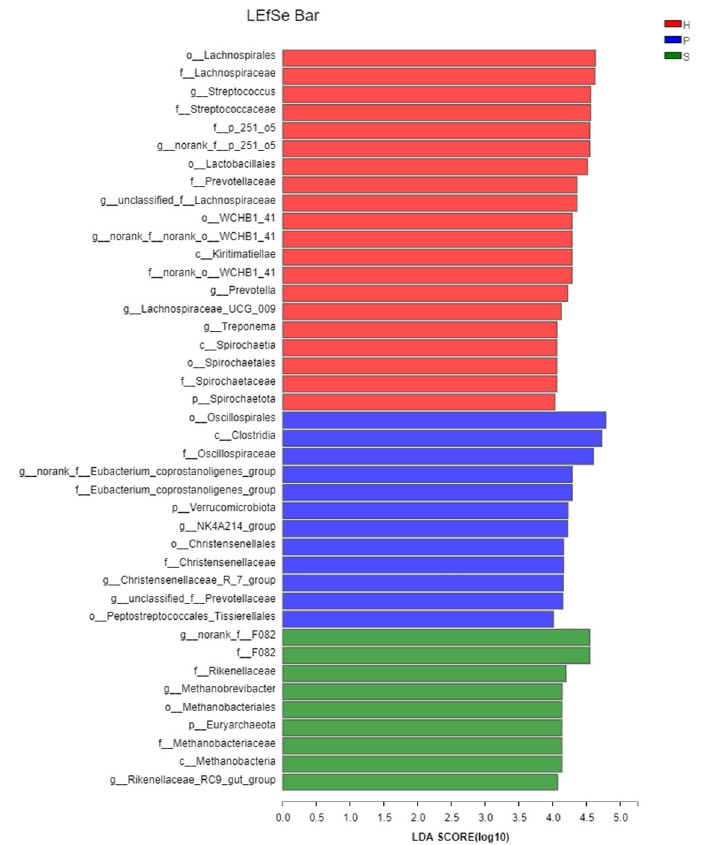
Figure 5. LEfSe discriminates difference of the fecal microbiota among group H, group P, and group S. 414 taxa were statistically different between groups ( p < 0.05), and only taxa with an LDA score of 4 or above were shown and ranked by the effect size in LEfSe. Red: group H; blue: group P; green: group S.